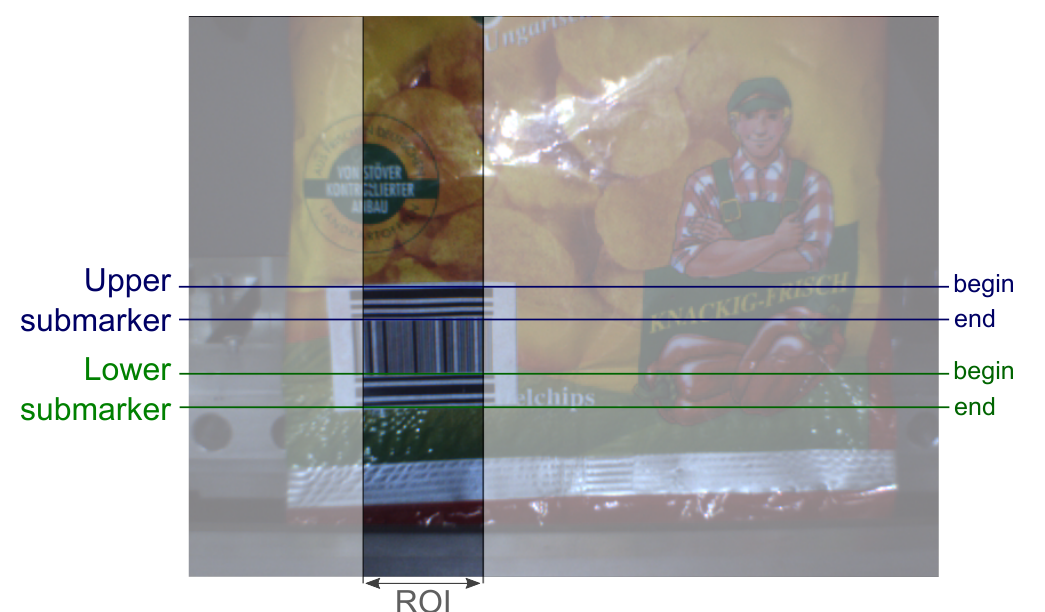
Figure 14. Definition of the Region of Interest (ROI) and the vertical bounds of the upper and lower marker parts within the